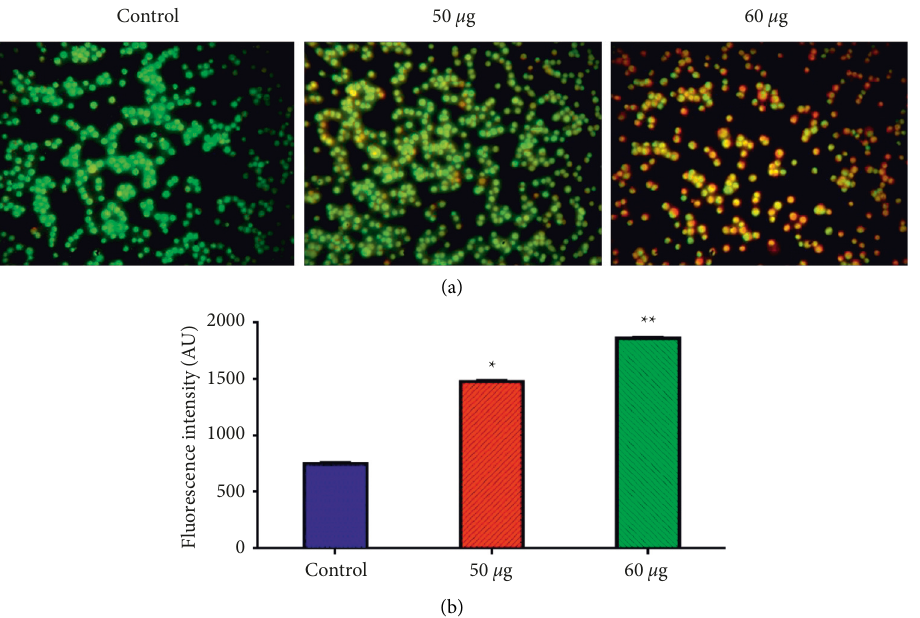
Figure 7: Effect of ZnO-TiO 2 -chitosan-farnesol NCs triggered apoptosis in MOLT-4 cells by AO/EtBr staining. Blood cancer cells ad- ministered with ZnO-TiO 2 -chitosan-farnesol NCs for 24h at two concentrations (50 and 60 μ g/ml), stained with AO/EtBr, and observed under a fluorescence microscope (a). The fluorescence image showing control MOLT-4 cells with green fluorescence, NCs (50 μ g/ml) treated cells with green and yellow fluorescence, and NCs (60 μ g/ml) treated cells with yellow and orange fluorescence (b). The values are displayed as the mean ± SD of triplicates: ∗ p < 0 . 05 vs. control; ∗∗ p < 0 . 01 vs.